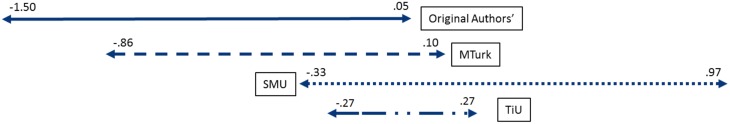
Threatened, securely attached participants should experience lower levels of loneliness if they wrote about comfort food as compared to if they wrote about new food.